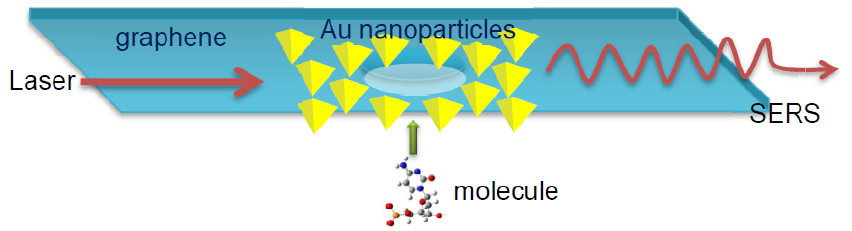
Figure 1. Schematic of the flow-through setup that allows single nucleotide to flow through in a graphene nanopore at plasmonic resonance upon the laser excitation.